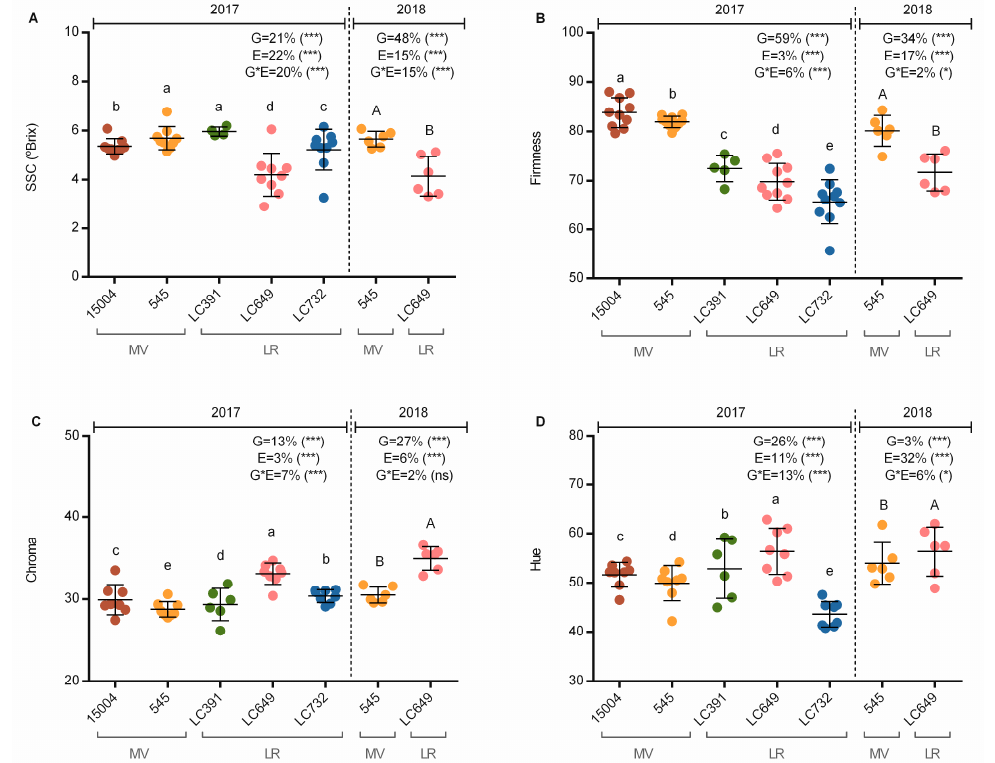
Figure 7. Differences between modern varieties (545, 15004) and landraces (LC391, LC649, LC732) for fruit quality traits. ( A ) Soluble solids content (SSC), ( B ) firmness, ( C ) chroma, ( D ) hue. Mean ± SEM calculated from 2017 (Exp7-Exp16) and 2018 trials (Exp1–Exp6). Within graphs, and for each year, different letters (2017, lowercase; 2018, capital letters) indicate significant differences between genotypes (Student–Newman–Keuls, p < 0.05). G, E, and G*E percentages indicate the relative contributions of genotype, environment, and genotype-by-environment interaction, respectively, to the total observed phenotypic variation. Level of significance: * p < 0.05; ** p < 0.01; *** p < 0.001; ns, not significant ( p > 0.05).